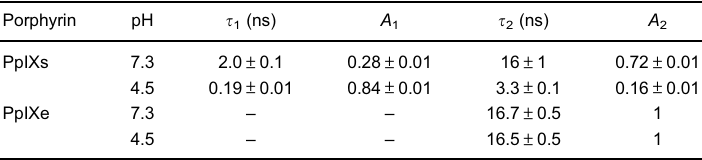
Data are reported as means ± SD. PpIXs: synthetic protoporphyrin IX; PpIXe: endogenous protoporphyrin